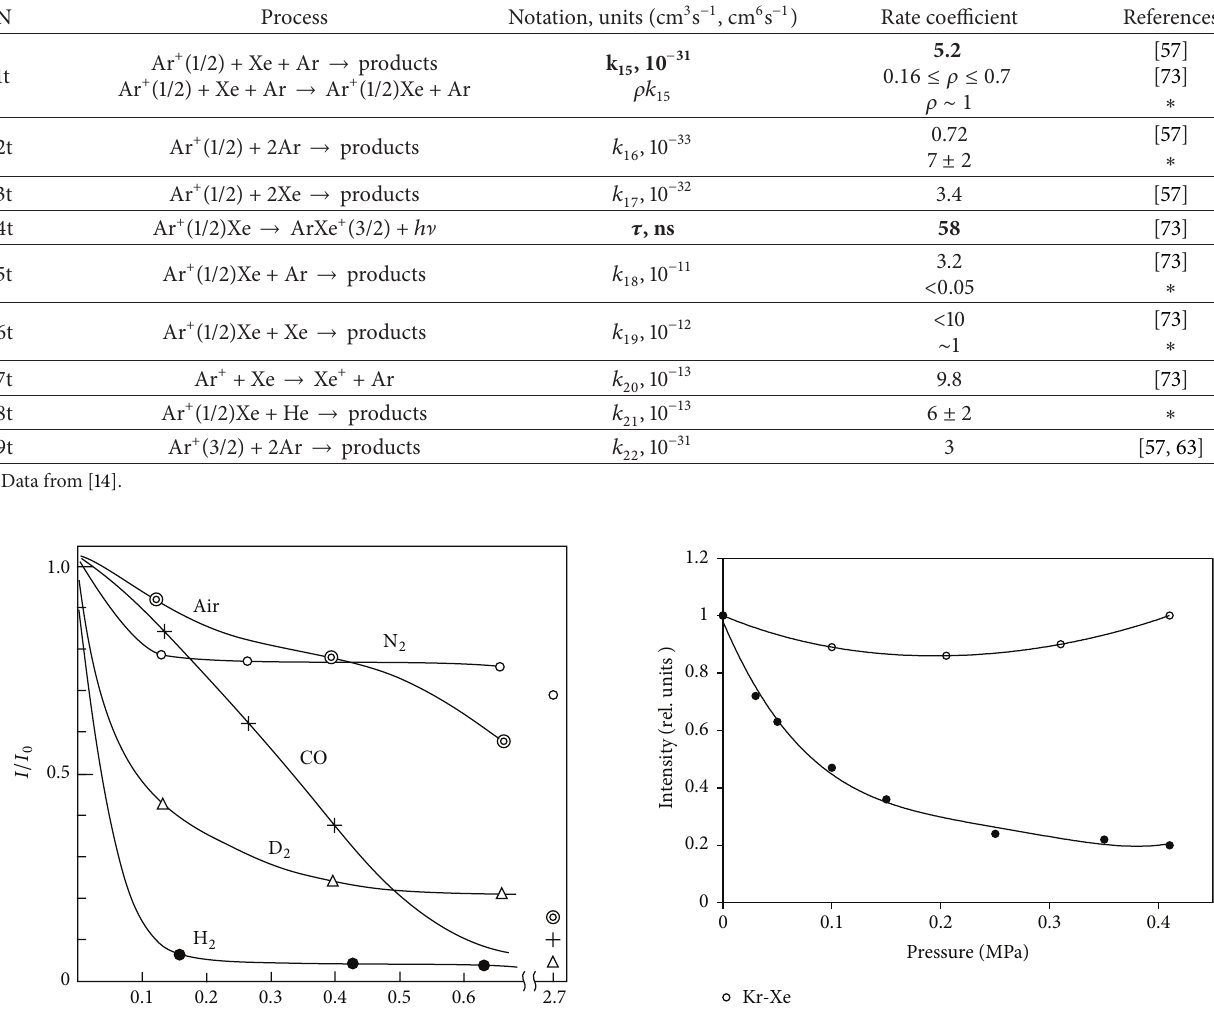
Table 4: Rate constants for processes in Ar-Xe-(He) mixtures.